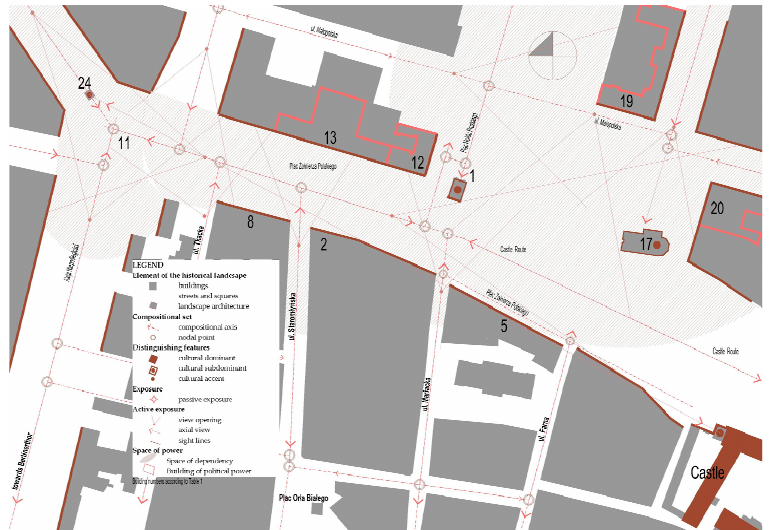
Figure 10. Landscape analysis of plac Ż o ł nierza Polskiego in 1989. After the Second World War, the spatial arrangement of the square was decomposed. As a result, the main axis of the square’s composition was shortened. The triaxial foundation was also corrected by removing the symbolic monument (11). It was replaced with a monument of dependence (Monument of Gratitude to the Soviet Army-24), which was situated on the central axis of the complex and visually connected with the accent—the tower of the ducal castle. There was a spatial connection between the two symbols of the state’s historical policy. However, the main change in the space of plac Ż o ł nierza Polskiego was the demolition of its main dominant, i.e. the building of the City Theatre. It was also decided not to rebuild the urban block, which formerly bordered on the theatre building from the north. In this way, an undefined and unnamed square (the future plac Solidarno ś ci) was created, and assigned various functions over time, such as a playground, a green square, and a public transport hub. On the northern side of both urban interiors, the buildings of ideological power were located, which were politically dependent on the Soviet sovereign (12, 13, 19). The southern part of the square, formerly associated with the Prussian space of power, was transformed by giving it a new cultural function (2, 8). The extensive communication system of the Castle Route was constructed along the main compositional axis of plac Ż o ł nierza Polskiego. The square had the character of an open urban interior with little legibility, where view openings dominated the closures of space (source: created by author).